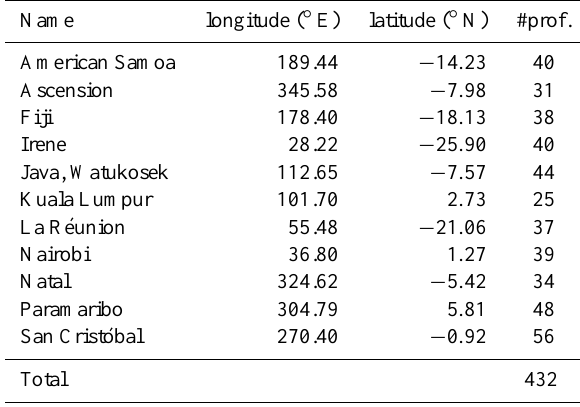
Table 5. Locations of SHADOZ stations used for the mean profile in Fig. 6. #prof is the number of profiles used in mean